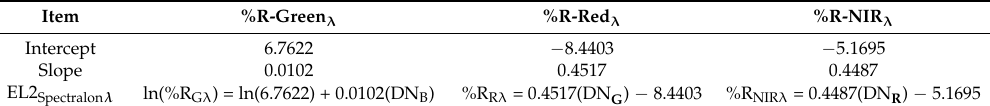
Table 11. EL2 equations from Dulux targets and calibration bracket per camera waveband. Table 12. EL2 equations from Spectralon targets and calibration bracket per camera waveband.